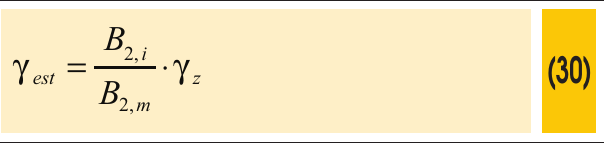
Figure 2 – Variation of the g / g ratio along the est whole height of the buildings, in both directions, for the columns